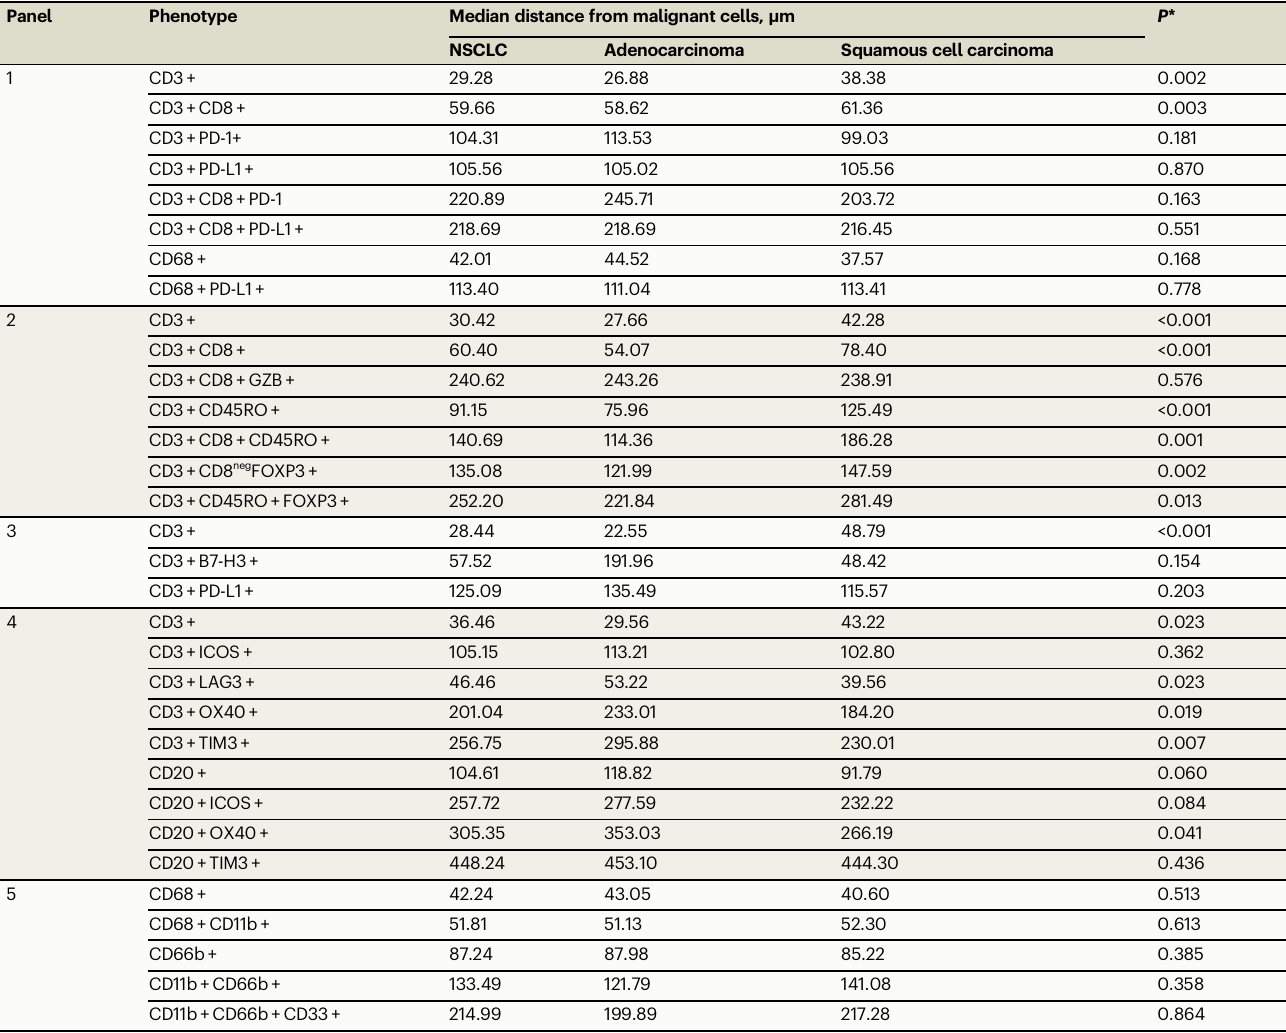
Table 2 | Median distances from malignant cells for various cell phenotypes according to histologic type ( n = 225)